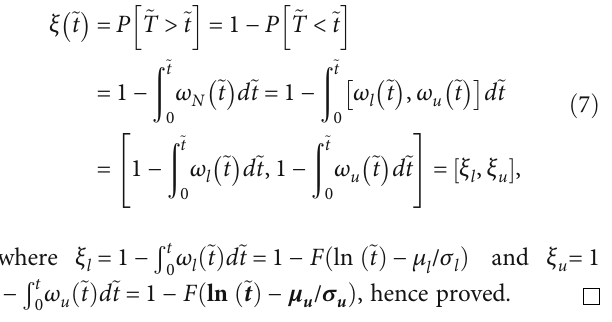
= ½ 0 : 3, 0 : 6 (cid:2) and (b) μ n